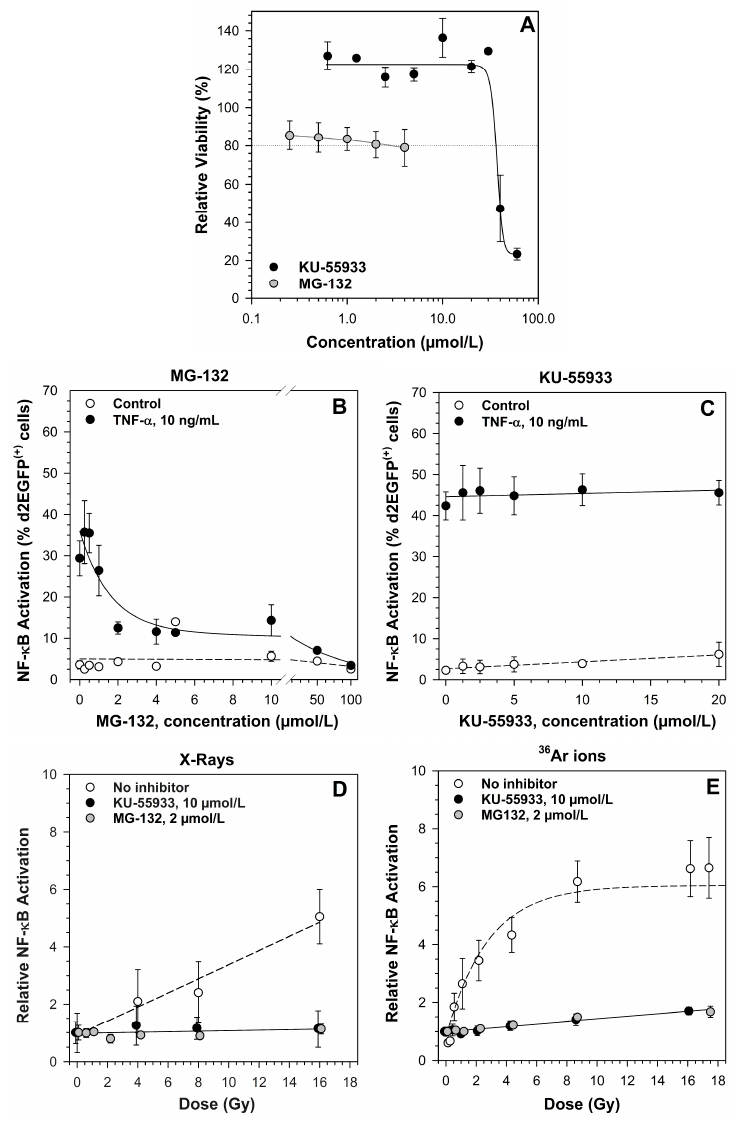
Figure 2. Ataxia telangiectasia mutated (ATM) and the proteasome are required for NF- κ B activation by low and high LET radiation. Means and standard error (SE) of two to three independent experiments with three replicates each are shown. The viability of HEK-pNF- κ B-d2EGFP/Neo L2 cells after treatment with increasing concentrations of ATM inhibitor KU-55933 and the proteasome inhibitor MG-132 was determined by means of the 3-(4,5-dimethylthiazole-2-yl-2,5-diphenyltetra- zolium bromide (MTT) test 100 h after adding the inhibitor. The dotted line indicates 80% relative viability ( A ); the effect of MG-132 ( B ) and KU-55933 ( C ) on TNF- α -induced activation of the NF- κ B pathway was determined in HEK-pNF- κ B-d2EGFP/Neo L2 cells preincubated with the inhibitor for 1 h before addition of 10 ng/mL TNF- α . Cells were detached and fixed with 3.7% formaldehyde after 18 h. NF- κ B-dependent d2EGFP-expression was measured by flow cytometry. The suppression of radiation-induced activation of the NF- κ B pathway by KU-55933 and MG-132 was determined in HEK-pNF- κ B-d2EGFP/Neo L2 cells after exposure to X-rays (200 kV, LET ~0.3–3 keV/µm, ( D ) and 36 Ar-ions (95 MeV/n, LET 270 keV/µm, ( E ) cells were preincubated with the inhibitor for 1 h and subsequently irradiated. After 18 h, NF- κ B-dependent d2EGFP-expression was measured by flow cytometry. The percentage of d2EGFP(+) cells was normalized to the mock-irradiated control. For 36 Ar ions, doses (Gy) were calculated from fluences (P/cm 2 ) according to Equation (1) (Section 4.5.3.).